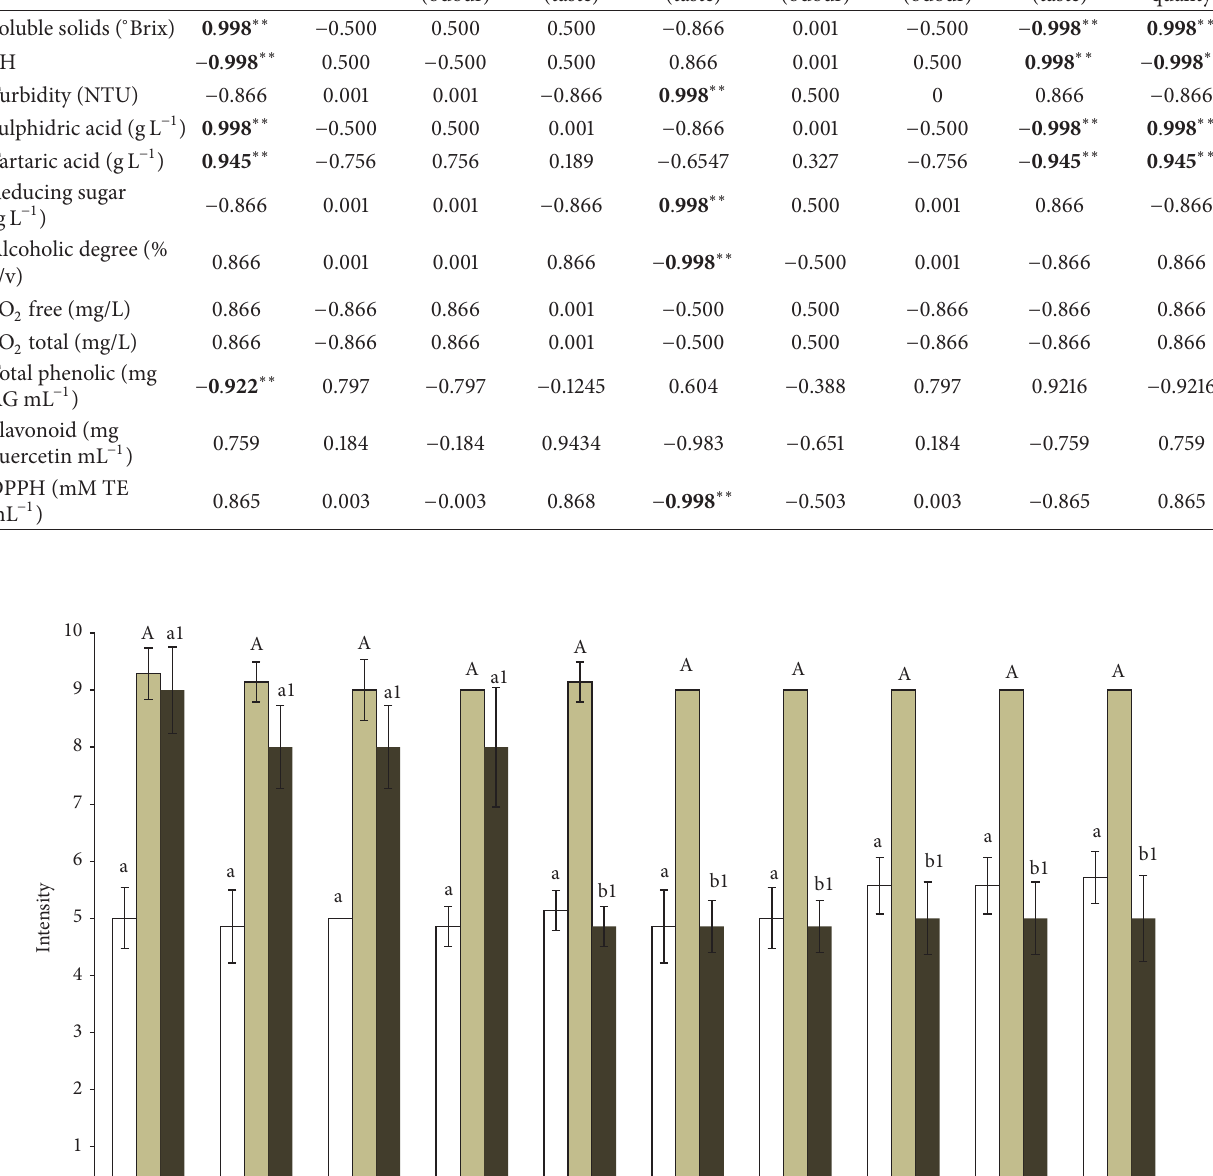
Fruity Fruity Astringent Overall (odour) (odour) (taste) quality